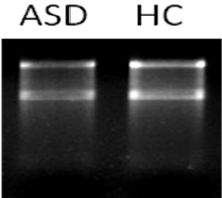
Figure 1. А garose gel analysis of the pooled RNA samples (Pooled samples from ASD group (ASD) and healthy controls (HC),